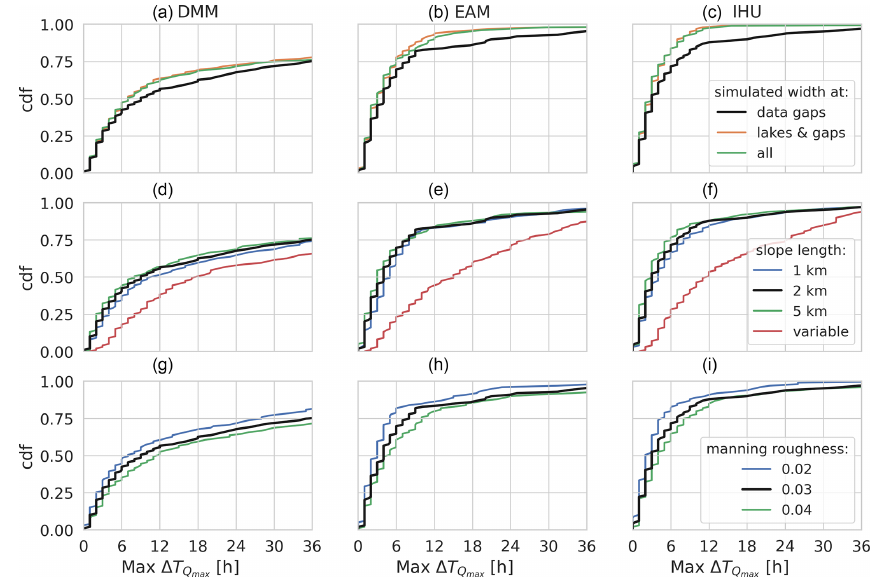
Figure F2. Sensitivity analysis of the relative difference in simulated peak timing for a case study in the Rhine basin for three parameters (rows) and for three upscaling methods (columns). Each plot shows the CDF of all output locations on the y axis and the relative difference in simulated peak magnitude on the x axis. The first row shows the sensitivity to the average MERIT Hydro vs. power-law-based channel width estimates; the second row shows the sensitivity to the minimum channel length over which the channel slope is estimated, and the third row shows the sensitivity to the Manning roughness coefficient. The black line is the default case in all